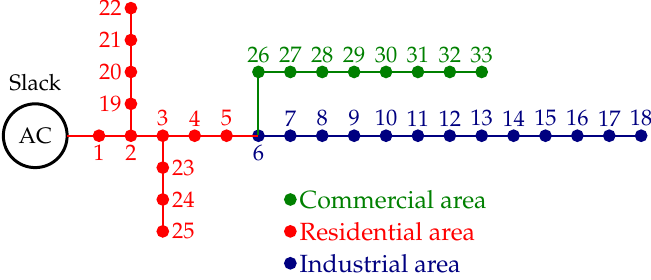
Figure 2. Schematic configuration of the IEEE 33-bus grid with load